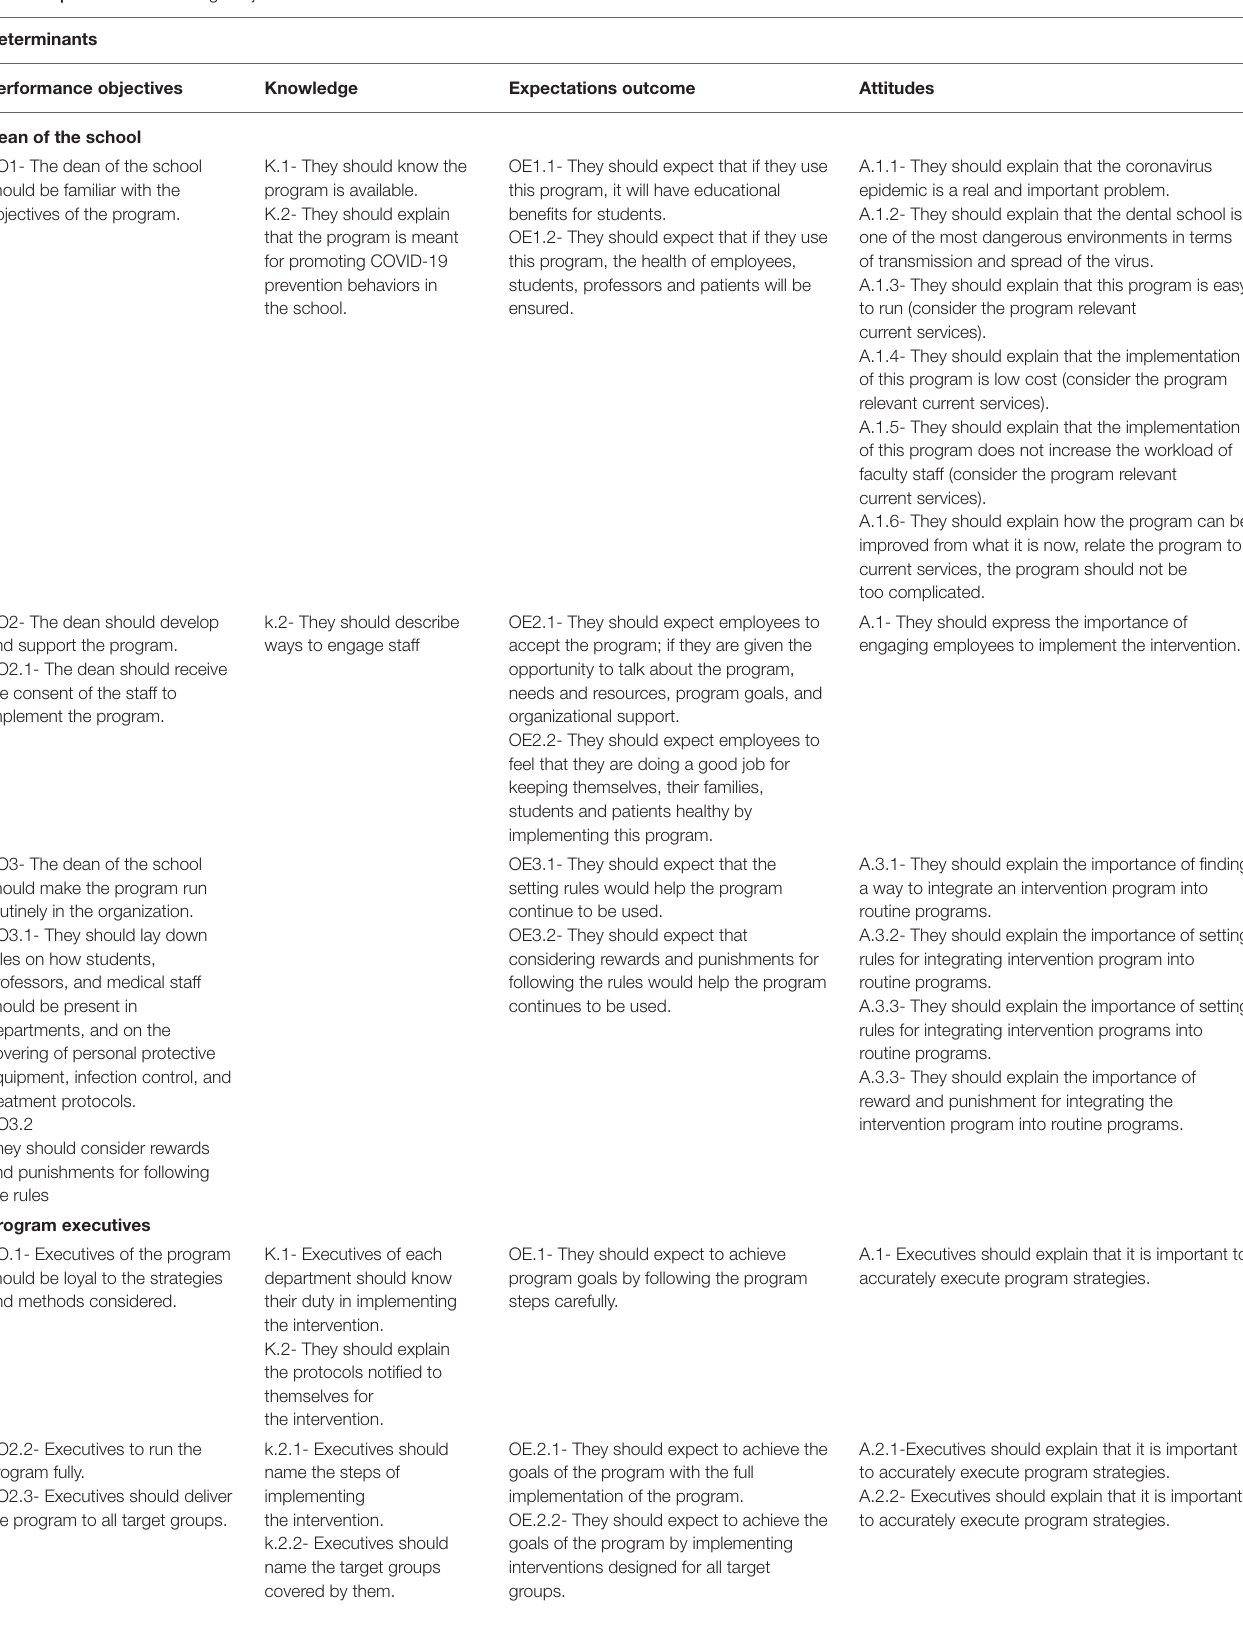
TABLE 6 | The matrix of change objectives for teacher and students.